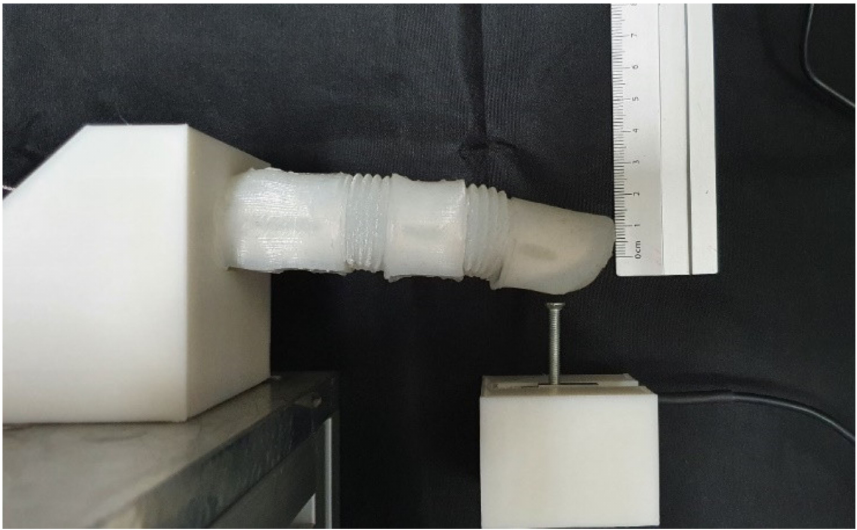
Figure 12. Illustration of a deflection measurement experiment being conducted. Comparisons of the measured and predicted deflections are shown in Table 3 and Figure 13. Figure 13 confirms the suitability of this analysis, as the theoretical and experi- mental results show similar trends with a similar